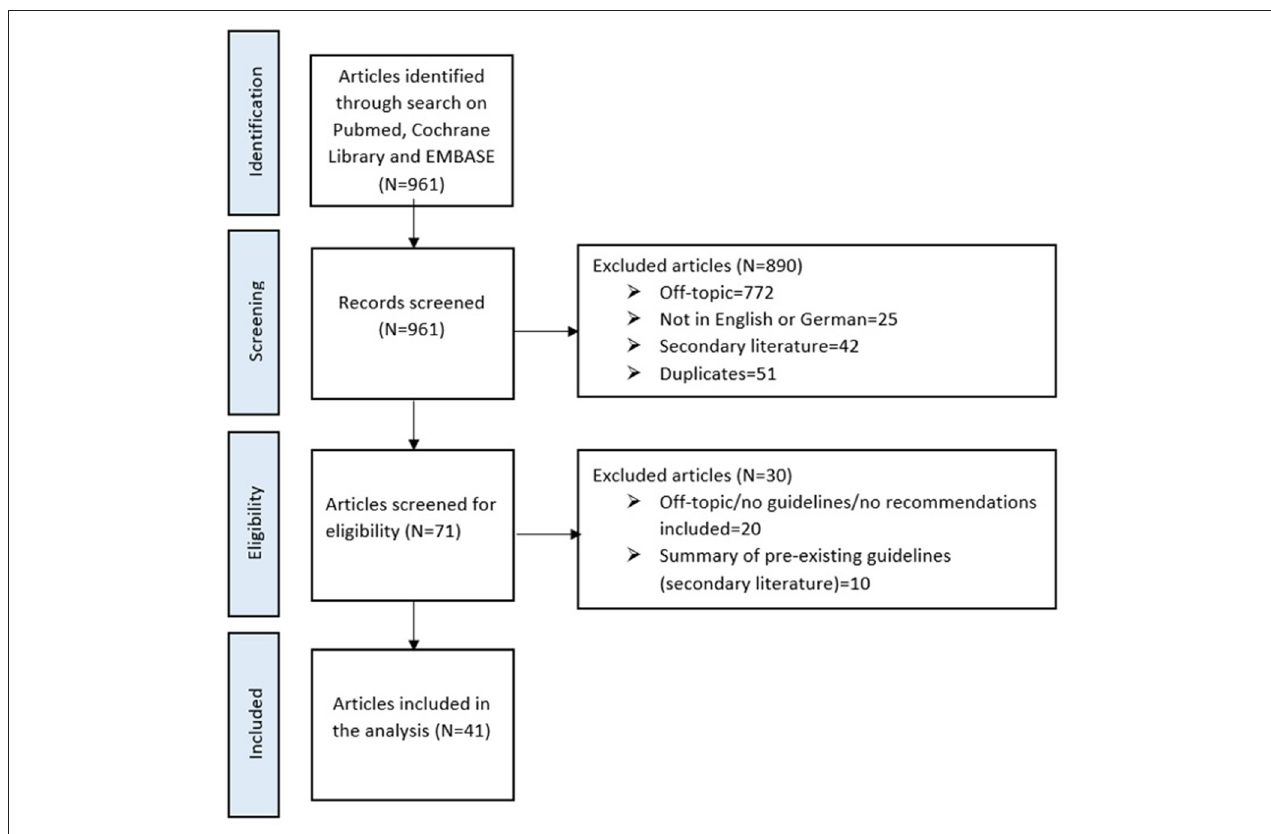
FIGURE 1 | Flow chart of the literature search and selection of articles to be included in this